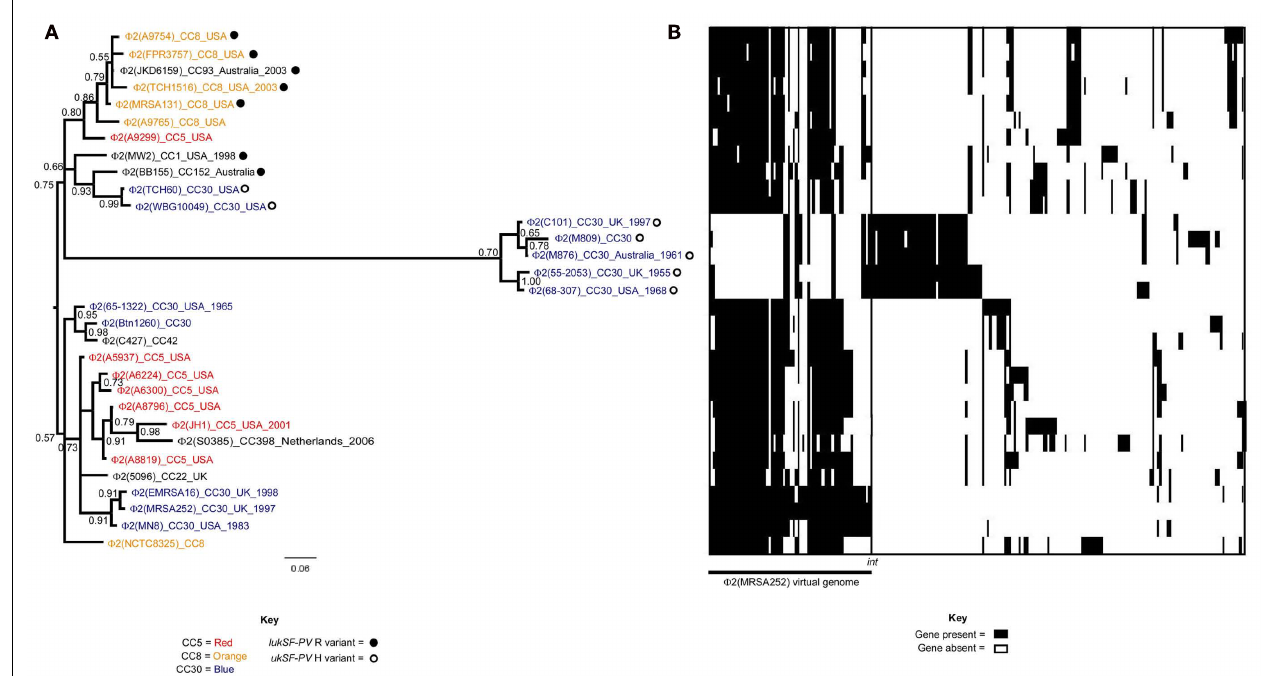
distribution of the lukSF-PV R and H variants is additionally mapped onto the phylogeny. (B) Presence/absence of 221 ϕ 2 genes is shown for each of the ϕ 2 prophage. Each horizontal line represents the genome of the adjacent ϕ 2 prophage in the phylogeny. Each vertical line represents a ϕ 2 gene.The color in the middle depicts if the gene is present (black) or absent (white).The genes are organized into virtual genomes, and the first genome shown in ϕ 2